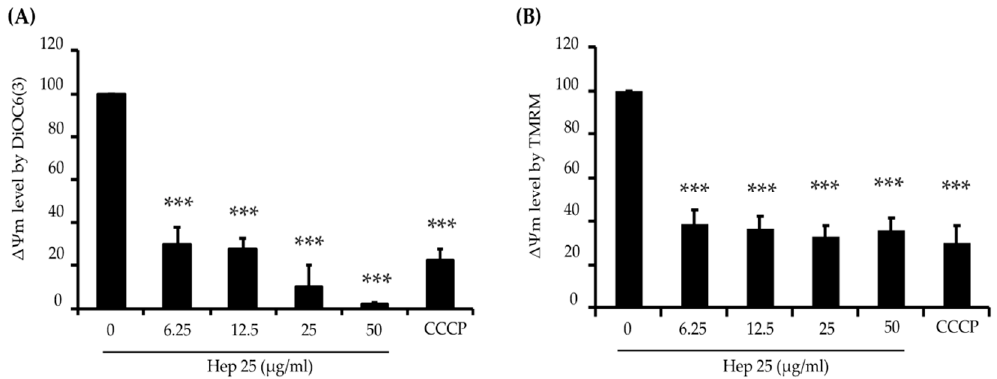
Figure 6. Mitochondrial depolarization caused by hep 25. Depolarization of the mitochondrial membrane was detected by DiOC6(3) ( A ) and TMRM ( B ) staining and analyzed using flow cytometry and quantification data. CCCP (50 µ M) was used as a positive control for disruption of the mitochondrial membrane potential ( ∆Ψ m). The results are expressed as the mean ± standard deviation of three independent experiments; *** p < 0.001.